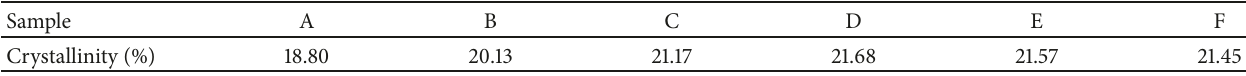
Table 2: The crystallinity of unmodified and EGDE-modified SF adhesives.